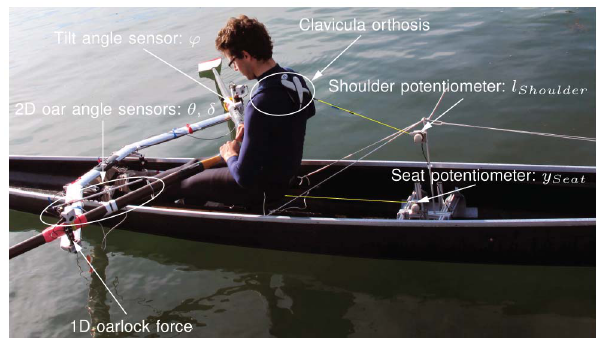
Figure 8. Data flow between the velocity model and the force models which constitute the rowing model. The rowing model gets the rower’s movement as an input and drives the rendering of the acoustic, visual, and haptic scenario.